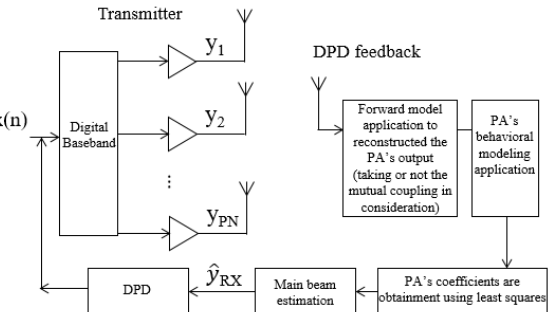
Figure 3. Block diagram representing the steps to apply the beam-oriented DPD using OTA diver- sity feedback method. feedback